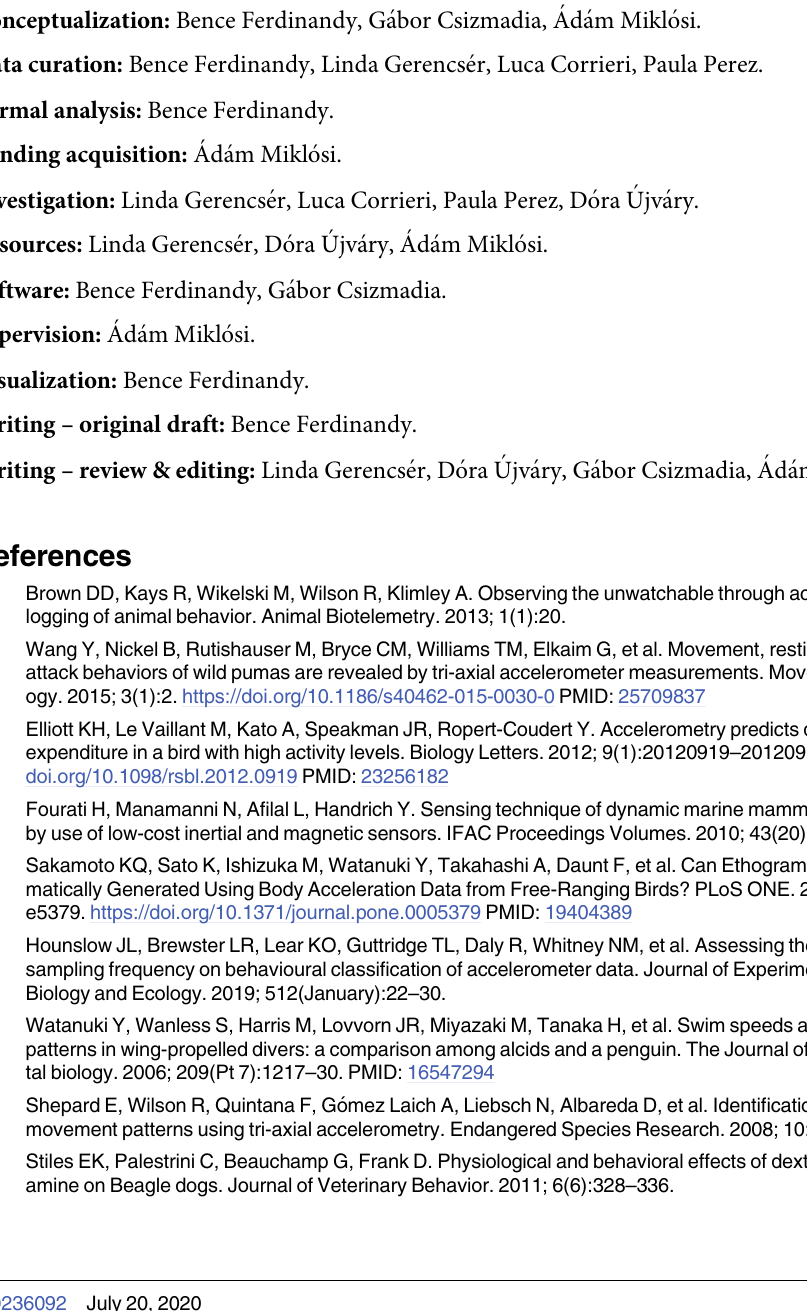
S2 Table. Definitions of the behaviour categories. S3 Table. The components of the